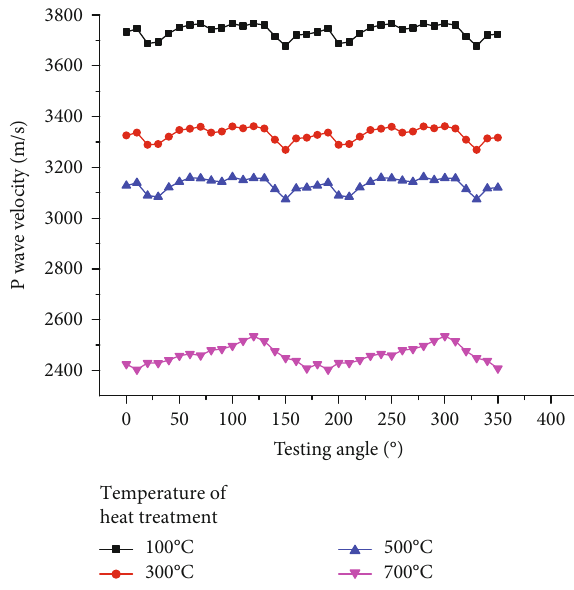
Figure 11: Variation rule of the circumferential wave